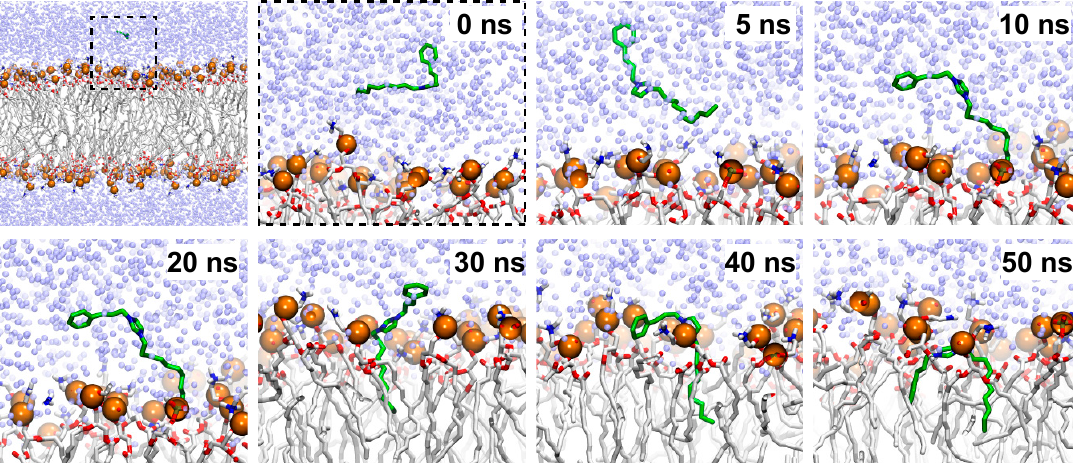
Figure 4. Distances between ILs [CDIM]Cl (black) and [CMIM]Cl (blue) and membrane center of masses (COMs) as a function of simulation time.